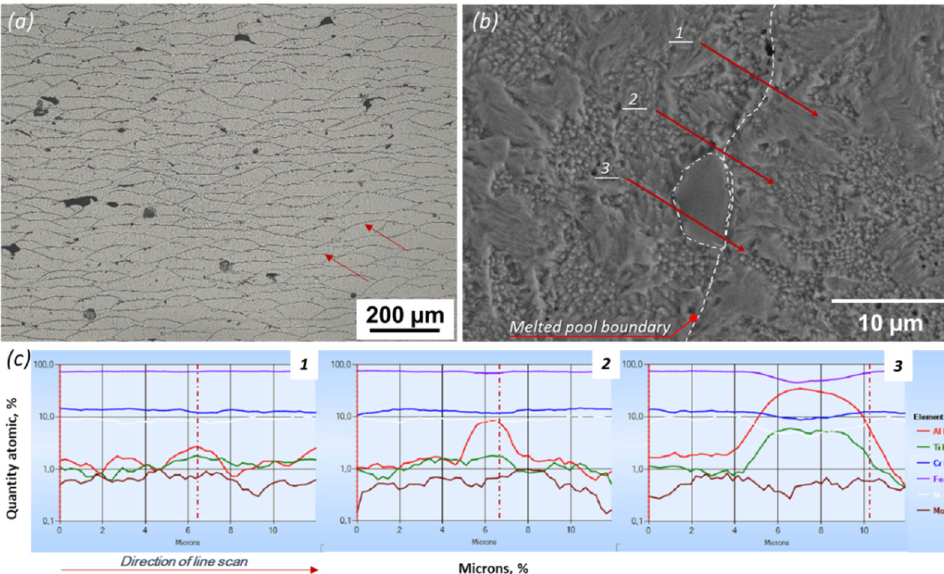
Figure 3. The microstructure of printed M789 in cross-section: ( a ) in as-printed condition (LOM), ( b ) SEM/EDS line analysis on the melted pool boundary (solution annealed condition), ( c ) compo- sition analysis in linear EDS scans along lines 1 ÷ 3 on ( b ), dash-dot line corresponds to the melt pool boundary.